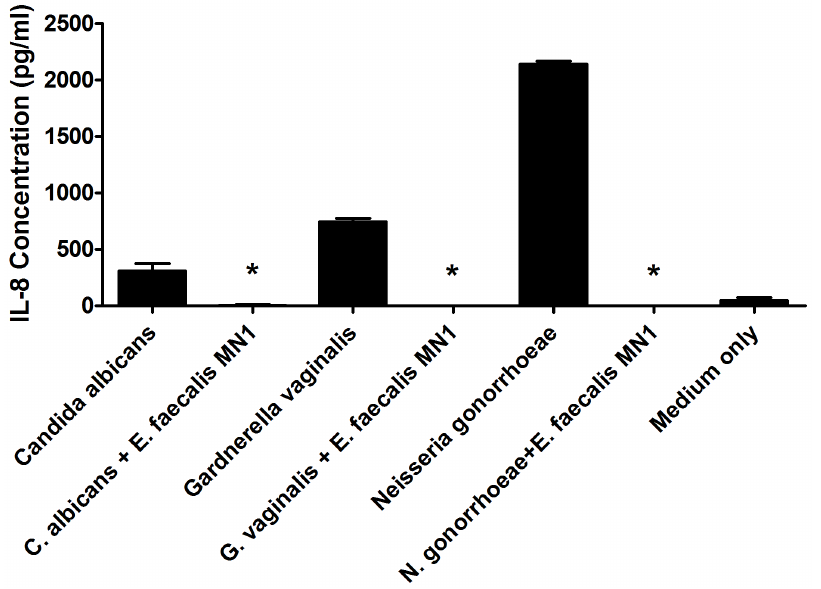
Figure 1. E.faecalis MN1 inhibits the IL-8 response of HVECs to vaginal pathogens. HVECs were incubated with C. albicans (2 6 10 5 CFU/ well), G. vaginalis (2 6 10 6 CFU/well), or N. gonorrhoeae (2 6 10 6 CFU/well) in the absence or presence of E. faecalis MN1 (8 6 10 6 CFU/well) for 6 h and IL- 8 production was measured by ELISA. *In each case, E. faecalis MN1 significantly inhibited the IL-8 response of the cells to the pathogen by individual Student’s t tests (p , 0.01). N=3 replicates.